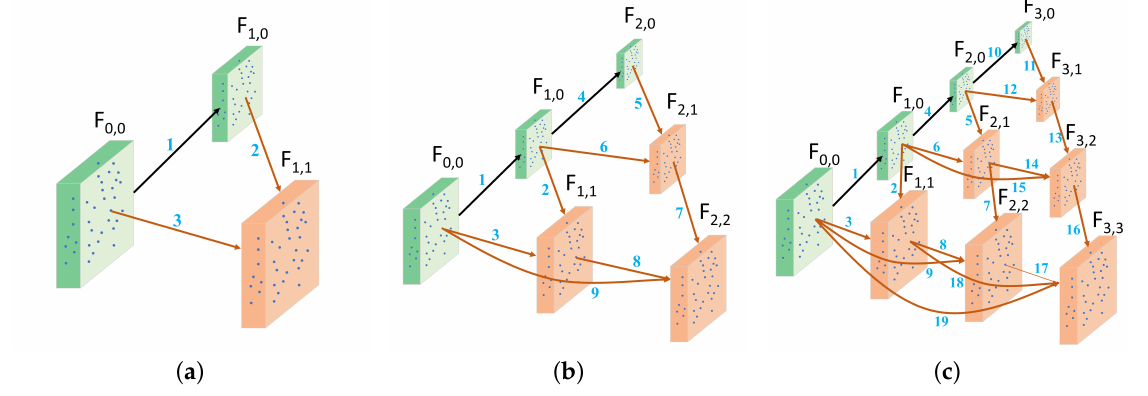
Figure 3. ( a ) 2-layer encoder-decoder structure, where the numbers in the figure represent the order of feature propagation in this structure. ( b ) 3-layer encoder-decoder structure, whose feature propagation is a further encoding, decoding and lateral propagation based on the completion of 2-layer encoder–decoder. ( c ) 4-layer encoder-decoder